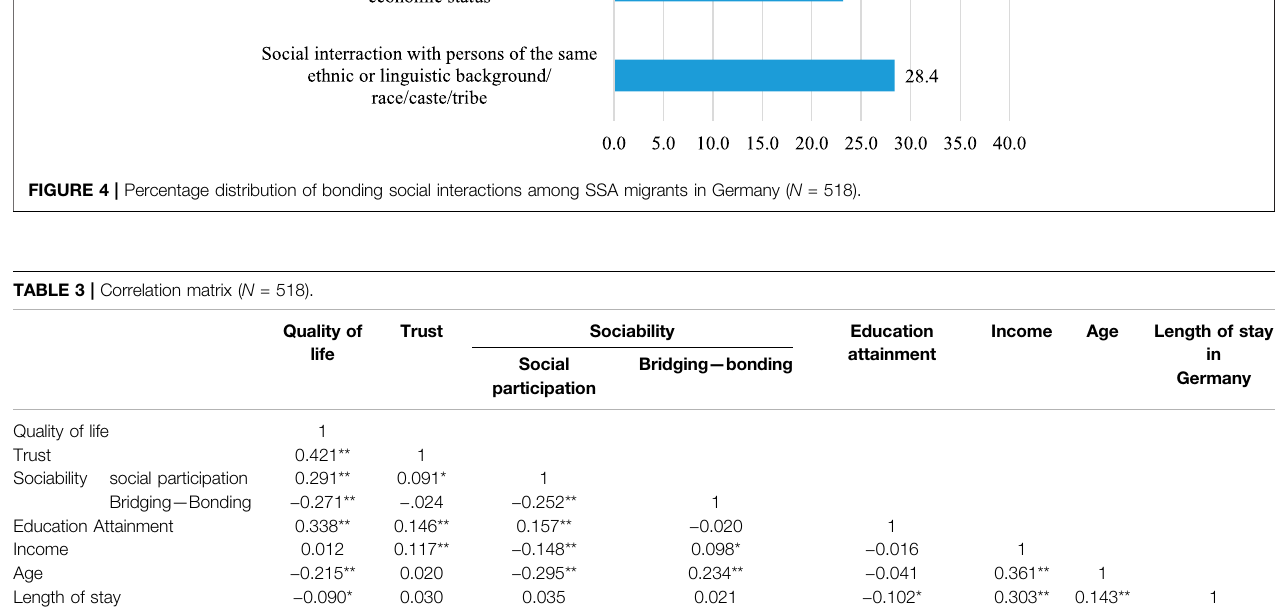
The change in effect size from Model 1 to Model 2 was signi fi cant for the total sample of males but not signi fi cant for the female participants (Change in F (cid:1) 1.948, p (cid:1) 0.089) The results from Model 1 also support trust as a signi fi cant predictor for QoL for the total sample ( β (cid:1) 0.339; p < 0.001) as well as for male ( β (cid:1) 0.274; p < 0.001) and female ( β (cid:1) 0.399; p < 0.001) participants separately. While the frequency of social participation was also signi fi cant for both genders and the total sample, the variety of social interactions in bridging or bonding was not signi fi cant for the female QoL score. After adding socioeconomic and demographic features in Model 2, trust maintained its signi fi cance for QoL for the total sample ( β (cid:1) 0.252; p < .001), for male ( β (cid:1) 0.239; p < 0.001) as well as for female ( β (cid:1) 0.260; p < 0.001). On the other hand, the frequency of social participation was not signi fi cant; however, whether these interactions were of bridging or bonding variety